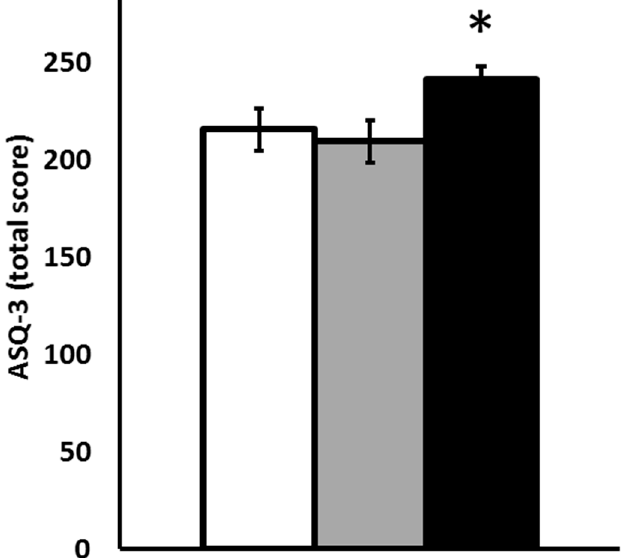
Figure 3. ASQ-3 are contrasted for children with leptin levels at 35-week PMA <500 pg/mL (open bars, N = 25), 500–1500 pg/mL (gray bars, N = 20) or >1500 pg/mL (black bars, N = 11). * p < 0.05 versus cohort with levels of 500–1500 pg/mL by Student’s t -test.